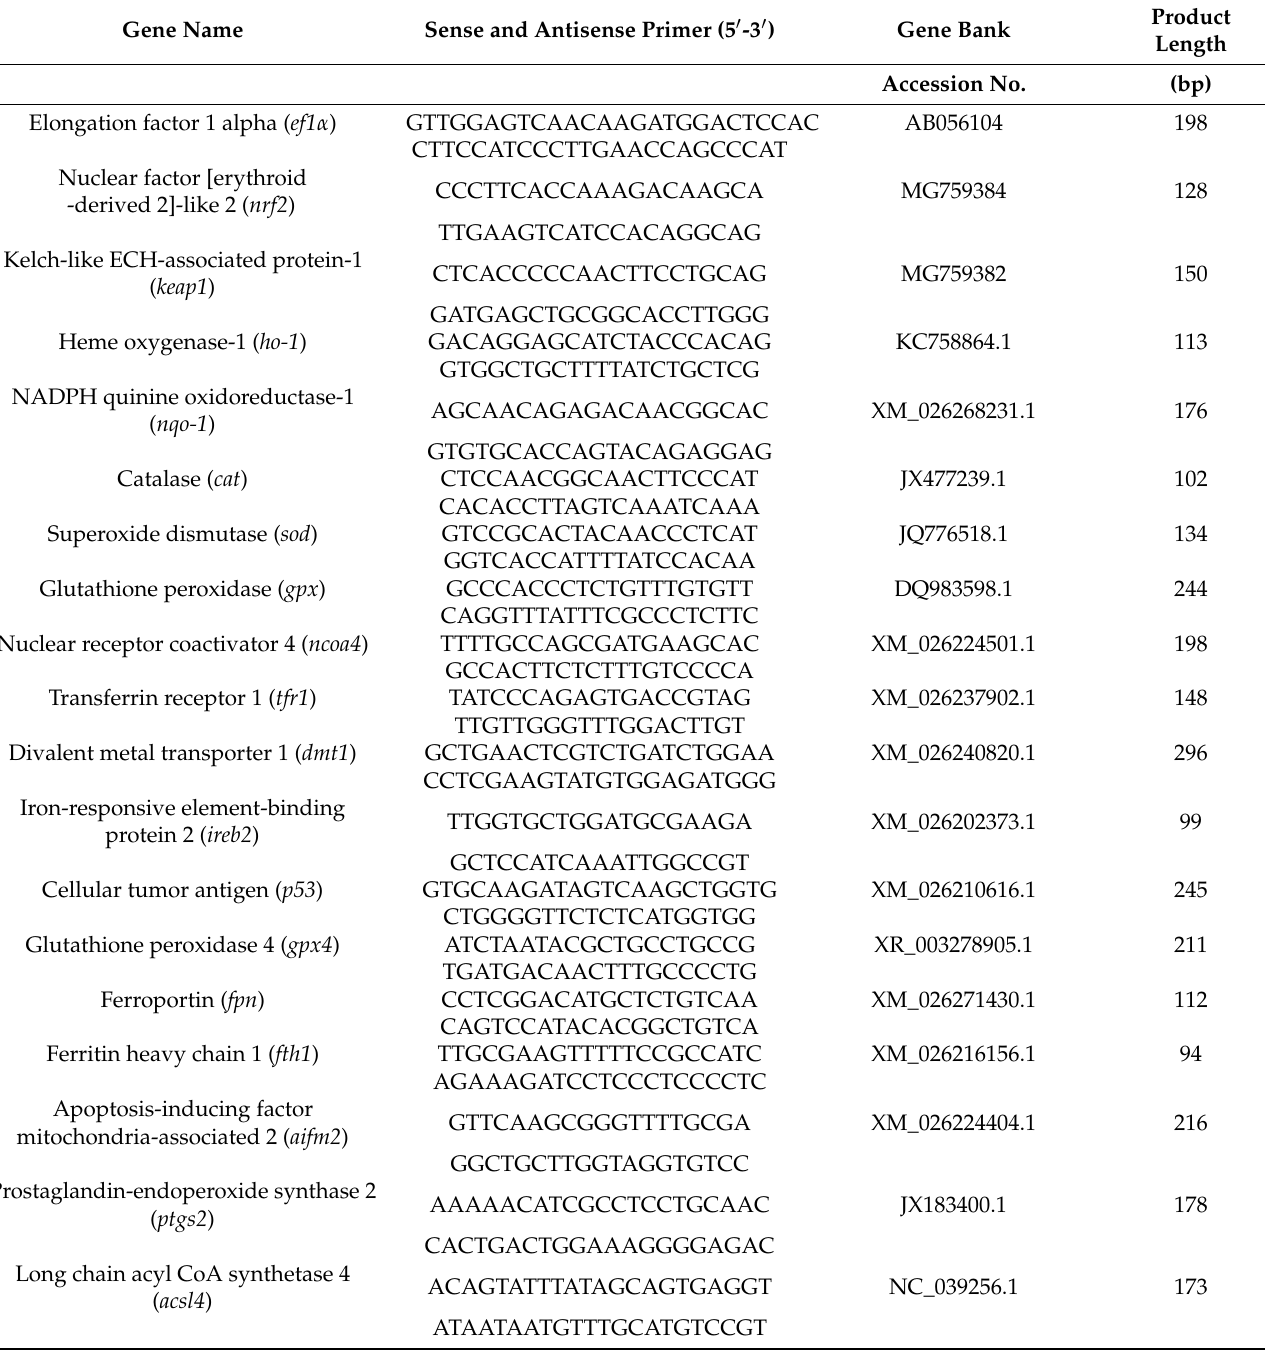
Table 3. Sequences of primers applied for quantitative real-time PCR analysis in gibel